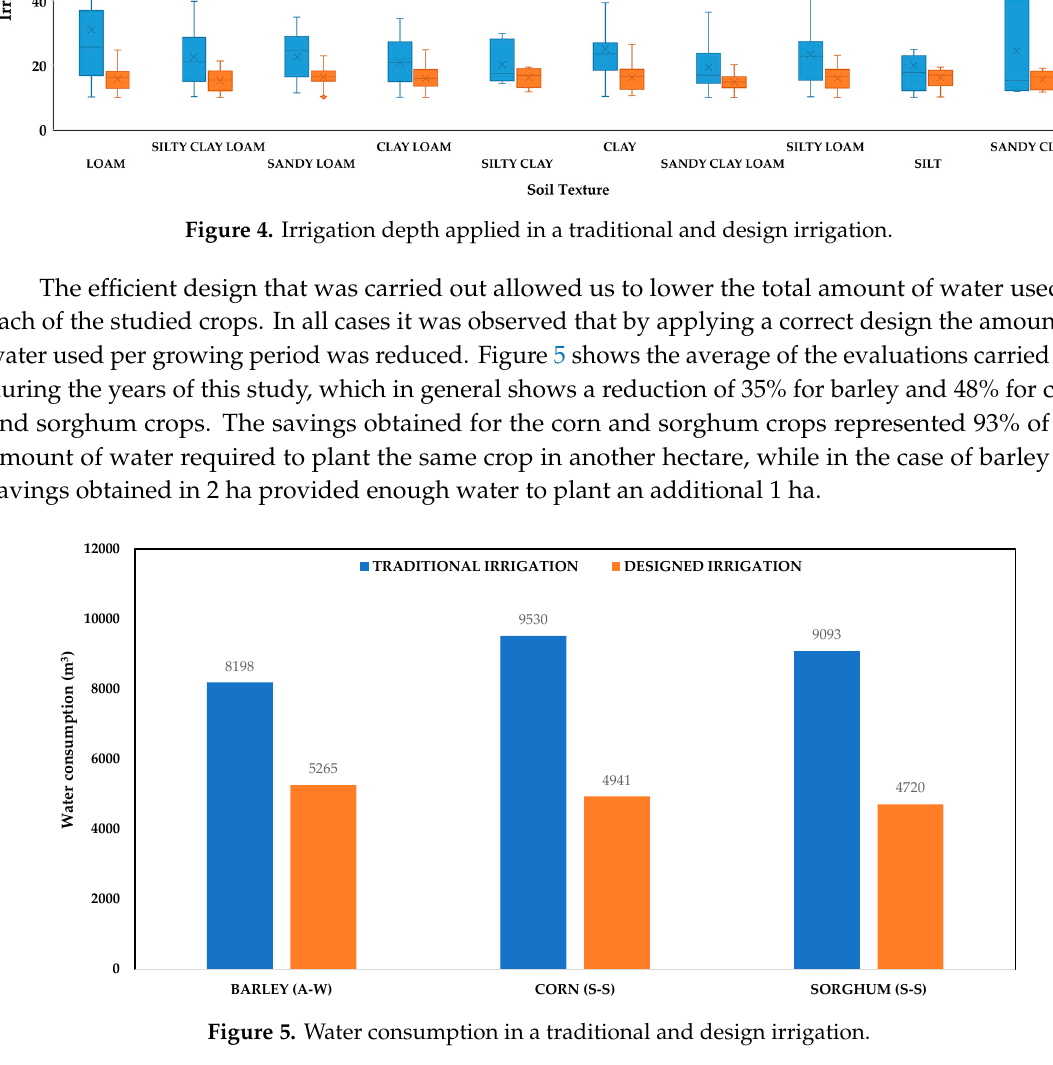
Figure 4. Irrigation depth applied in a traditional and design irrigation.